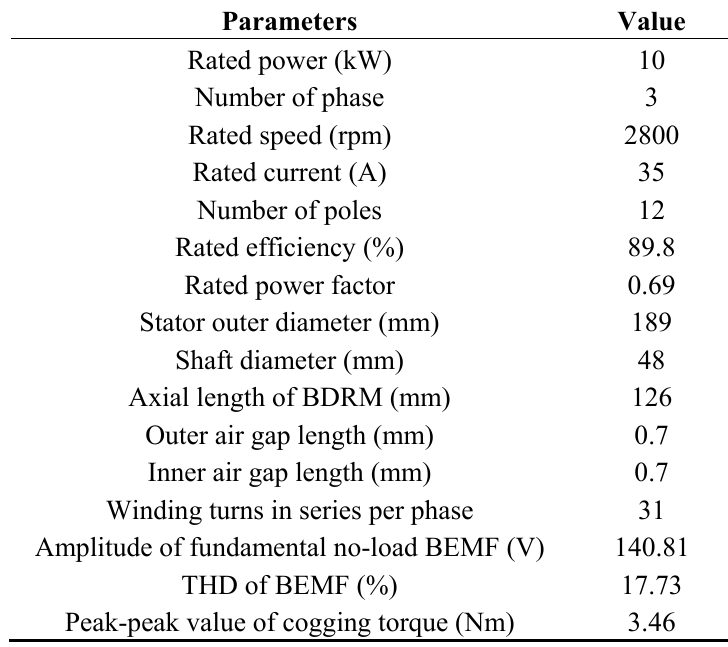
Table 3. Parameters of the